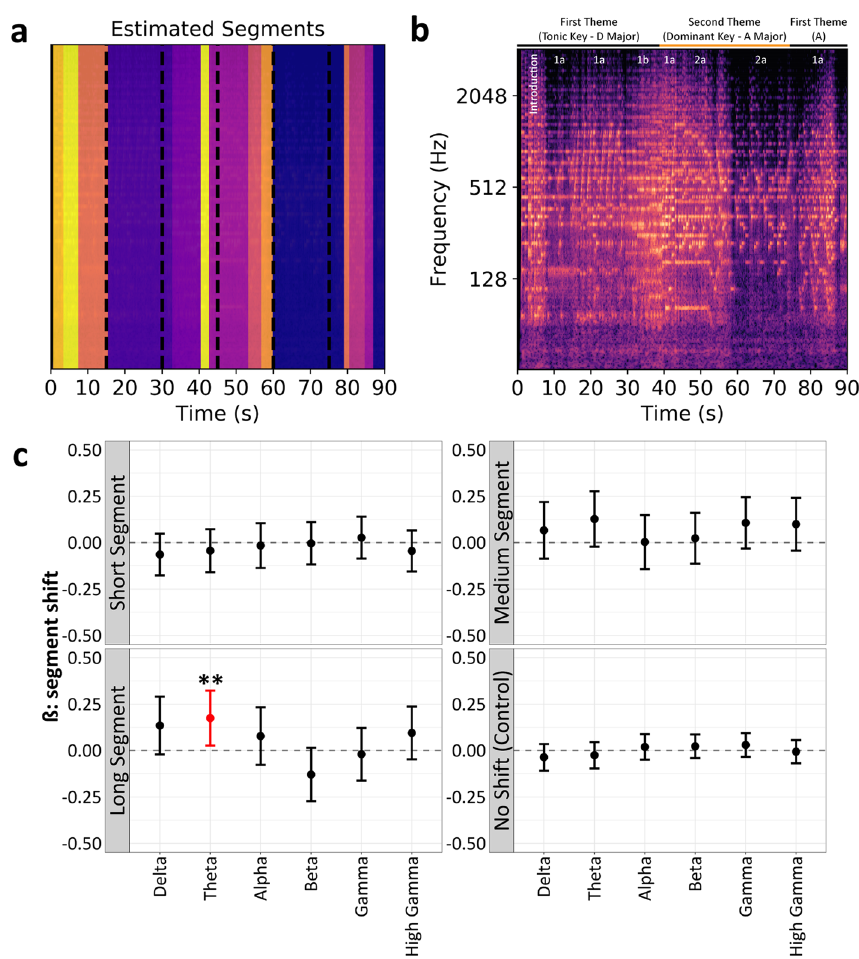
Figure 5. Enhanced frontal theta activity during shifts from long musical segment boundaries. ( a ) Detected segments for Mozart’s K448 with dashed lines indicating 15-s window boundaries used for our IED- related analyses. ( b ) Constant-Q spectrogram of K448 overlay with annotations from a theoretic analysis of the exposition of the first movement of Mozart’s K448 (i.e., K448’s musical score). ( c ) An assessment of the association between different Stereo-EEG powerbands and musical segment shifts (short = 3-s or less, medium = 3–10 s, long = 10-s or more, control = periods of no segment shift). There was a significant association between increased frontal theta activity and transitions from longer musical boundaries (ß = 0.17, % increase = 19.10, p = 0.002). All other powerbands and musical segment categories showed nonsignificant associations. ß values above zero reflect increased power, and ß values below zero reflect decreased power during a musical segment shift. Significance at * p < 0.05, ** p < 0.01, *** p <